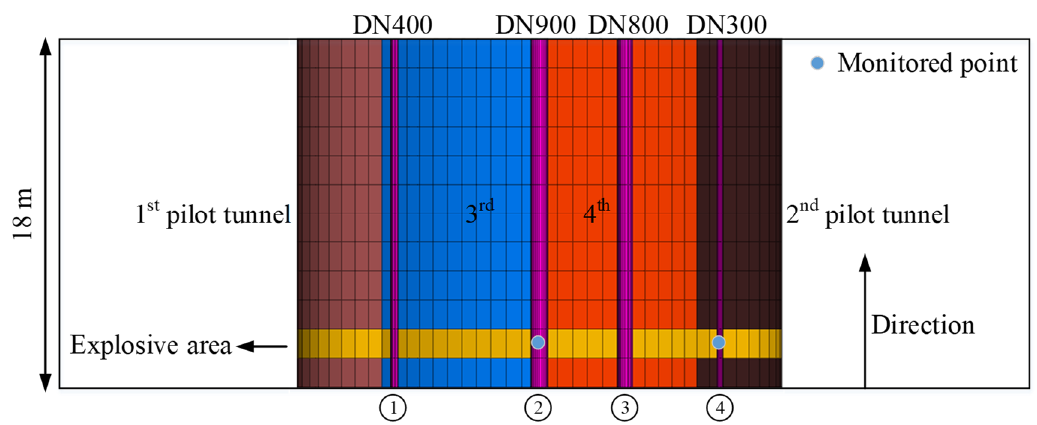
Figure 8. Relative location between pipelines and subway station.